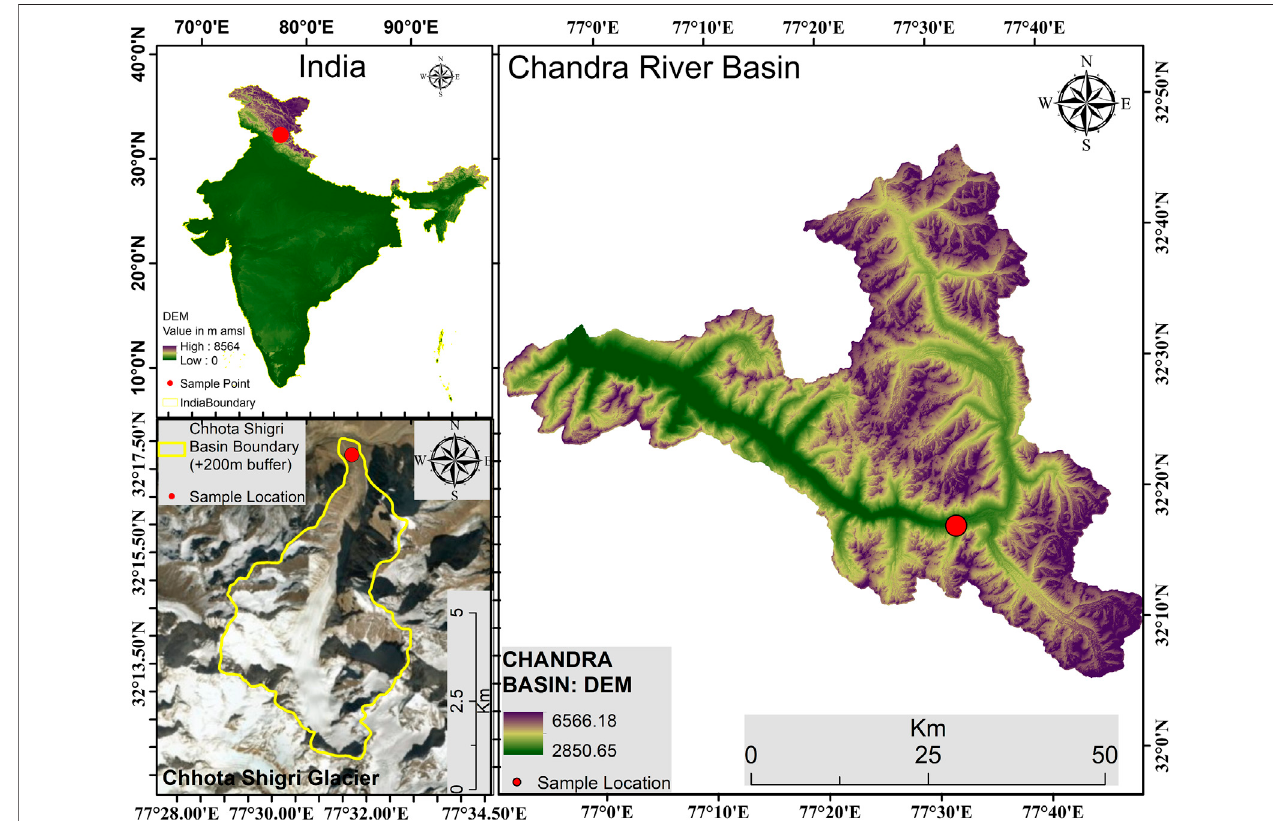
FIGURE 1 | Map showing the location of the study area. Chhota Shigri (CS) lies in the Chandra river basin of Pir Panjal range which is in the transition zone of Westerly and Indian Summer Monsoon. International boundaries are only for representation purpose.